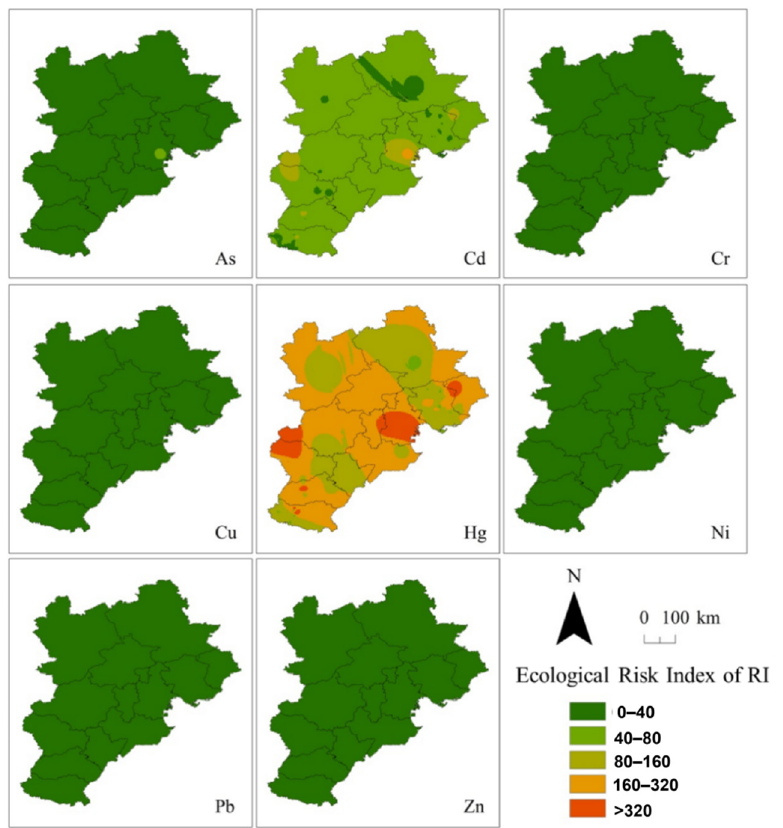
Figure 5. Proportion of coking plants causing ecological risk to the surrounding soil.